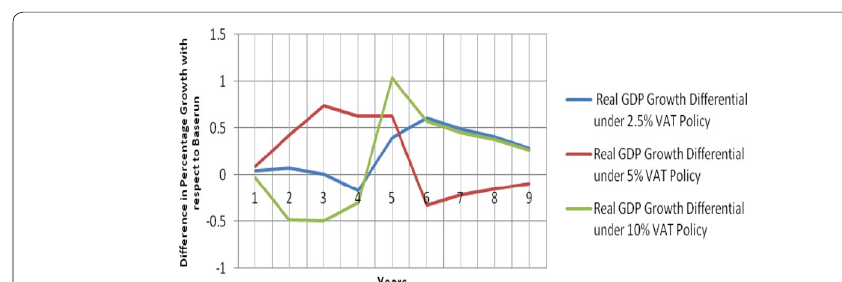
Fig. 5 Impact of VAT policy on real GDP growth differential